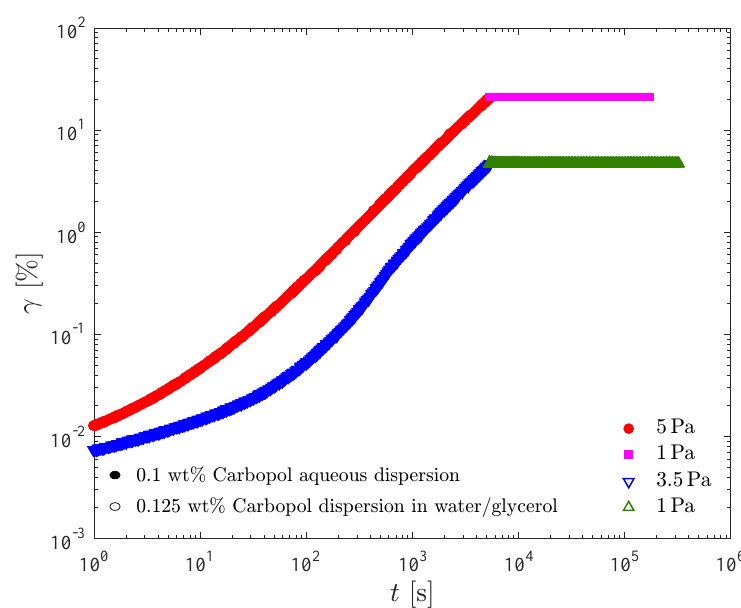
Figure 10. The strain evolution in the creep-recovery test for two Carbopol